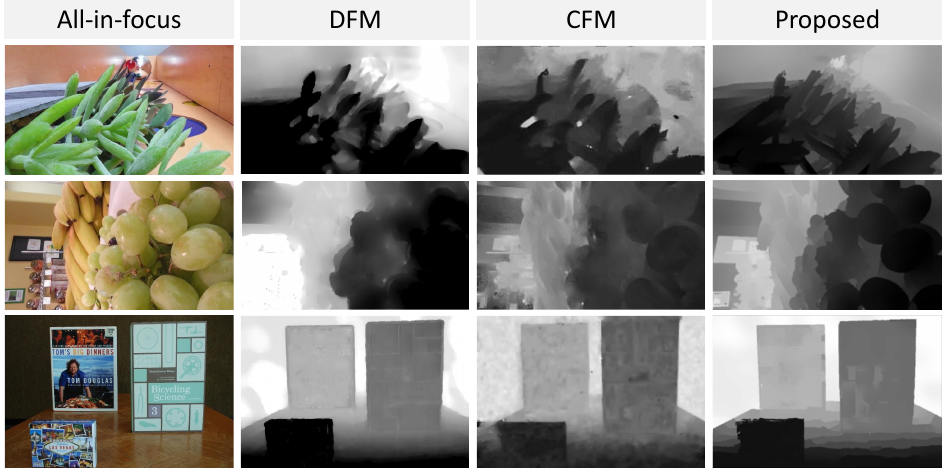
Figure 20. Qualitative evaluation (dataset from DFM [18]) with state-of-the-art methods. First column shows all-in-focus image, second: result from DFM [18], third: CFM [52], fourth: the proposed method. The proposed method provide detailed and clean edges, and third row has clean background while other methods failed on textureless region (background). Note that depth images for CFM [38] and DFM [18] methods were cropped from the original